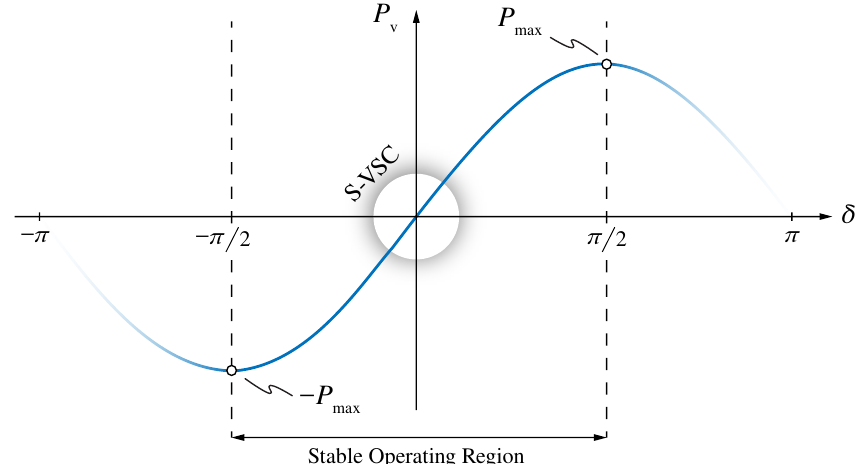
Figure 8. Power angle relationship of a synchronous generator with highlight of the S-VSC operating